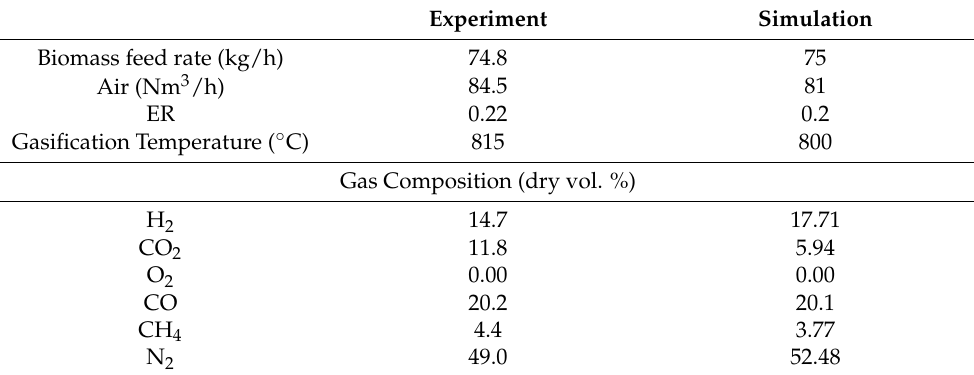
Table 6. Compared Simulation Results with Experimental Results.